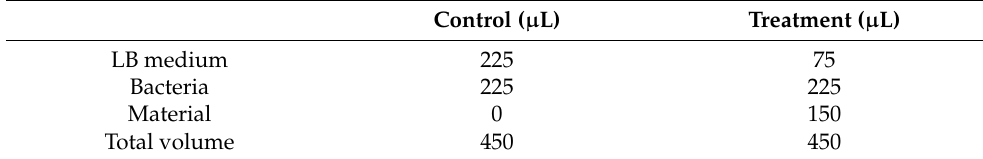
Table 1. Volume ratios for the antimicrobial activity